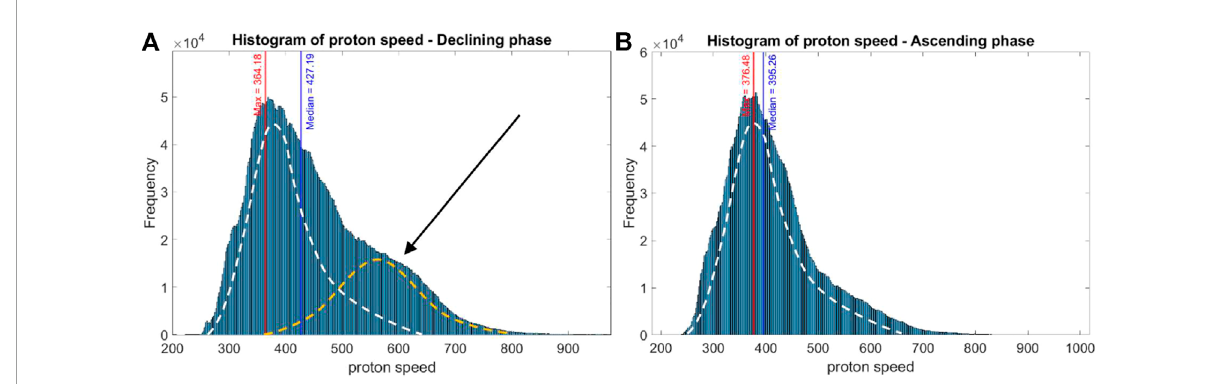
FIGURE 2 (A) Distribution of ion speed (km.s −1 ) between 01 January 2002 and 22 October 2009 and between 23 October 2014 and 09 September 2019 corresponding to declining phases of the solar activity. (B) Distribution of ion speed for opposite periods (km.s −1 ), corresponding to ascending phases of the solar activity. The maximum of the distribution (i.e., the most probable value) and median are also plotted on the two figures. The white dotted lines are an approximation of the shape of the distribution during the ascending phase (2b), while the yellow dotted line represent the potential contribution of the coronal-hole-origin plasma with a peak at 600 km s −1 (pointed by the black